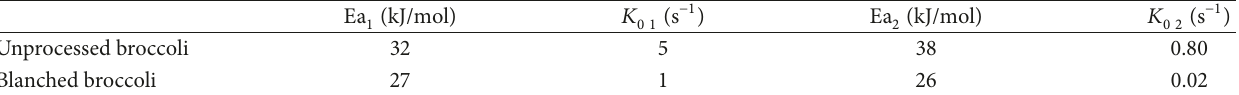
Table 2: Activation energies and frequency factors obtained from the kinetic model through the Arrhenius